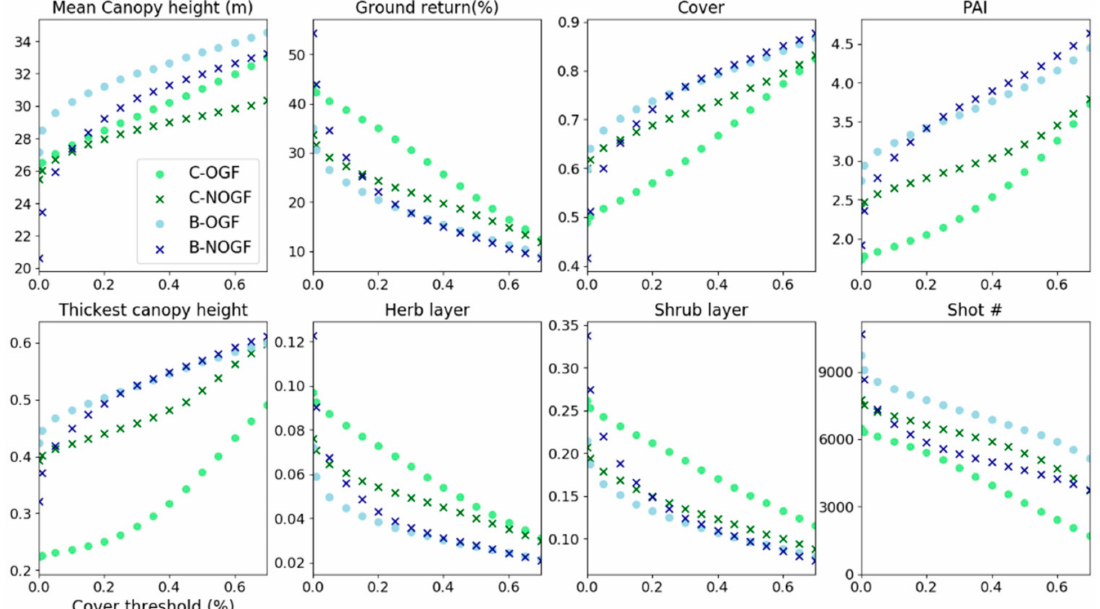
Figure 5. Plots showing the impact on selected structural metrics of removing from the study all GEDI shots with a canopy cover below the given value, shown on the x -axis for all plots. Symbols as for Figure 4. Bottom right-hand graph shows the number of eligible shots on the y